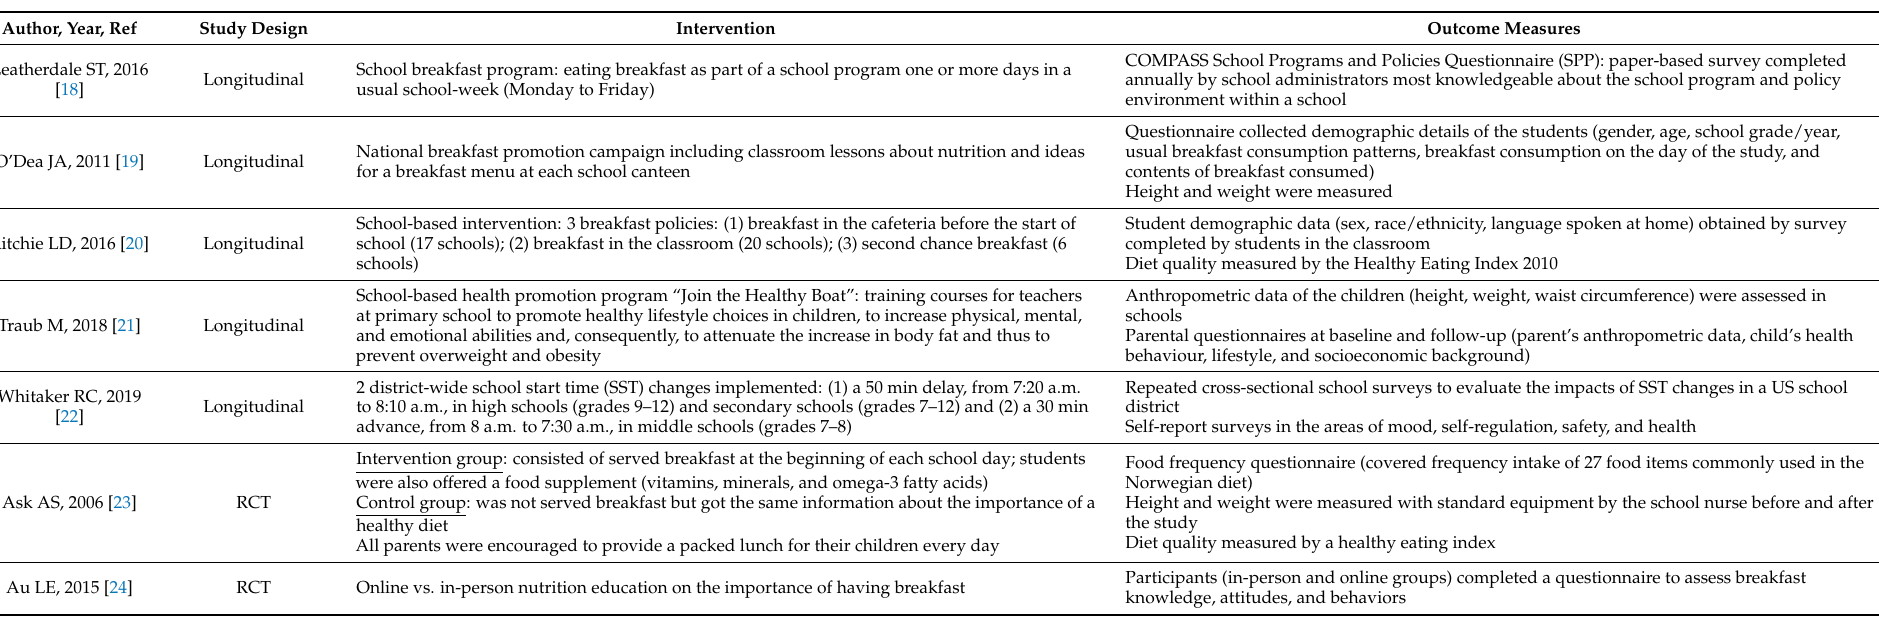
Table 3. Type of intervention and outcome measures in longitudinal studies and RCTs included in the systematic